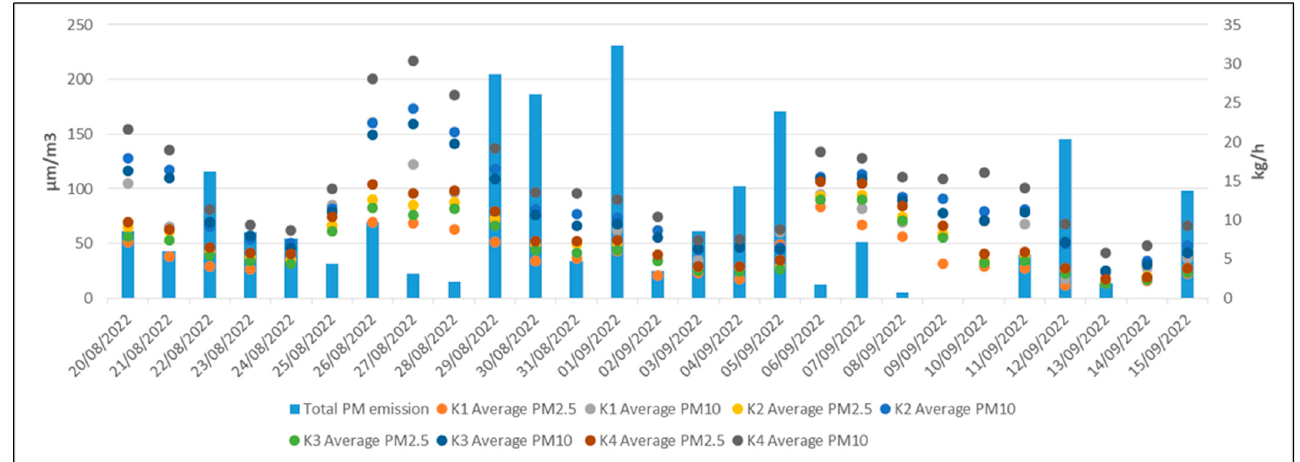
Figure 11. Estimated total cruise ship PM emission vs. PM 10 /PM 2.5 daily average ambient concentrations for all measurement locations over the experimental period.